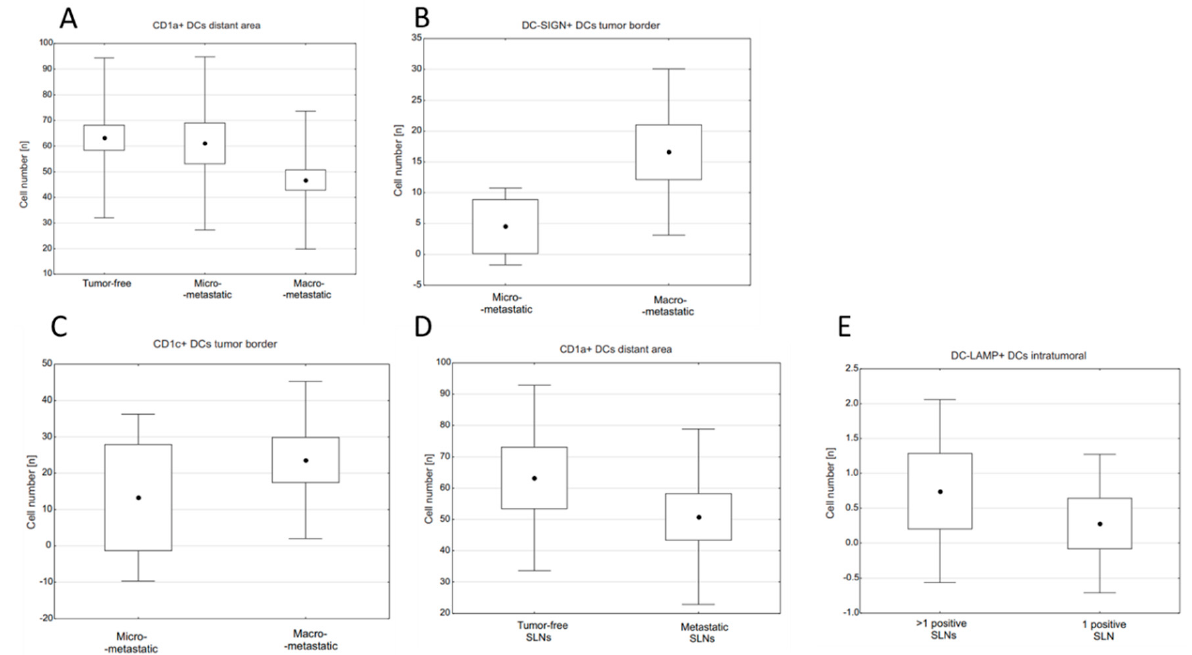
Figure 1. Relationships between densities of DC subpopulations and type of metastasis in SLNs or number of positive lymph nodes: ( A ) CD1a+ DC densities in the distant area of tumor-free, micrometastatic, and macrometastatic SLNs, p = 0.055; ( B ) DC-SIGN+ DC densities at tumor margin in micro- and macrometastatic SLNs, p = 0.002; ( C ) CD1c+ DC densities at tumor margin in micro- and macrometastatic SLNs, p = 0.031; ( D ) CD1a+ DC density in lymphoid tissue (“distant area”) with reference to presence or absence of secondary tumor in SLN, p = 0.054; ( E ) intratumoral DC-LAMP+ DC density with reference to presence or absence of metastases in lymph nodes other than investigated SLN, p = 0.013. ( A ) Kruskal–Wallis ANOVA test: the central point is arithmetical mean, box is mean ± standard error (SE) and whiskers are mean ± standard deviation (SD). ( B – E ) U Mann–Whitney test: the central point is arithmetical mean, box is mean ± 2xSE and whiskers are mean ± 0.95xSD. p -value < 0.05 was considered significant. Table 2. Densities of investigated DC subpopulations in different compartments of tumor-free, micrometastatic, and macrometastatic